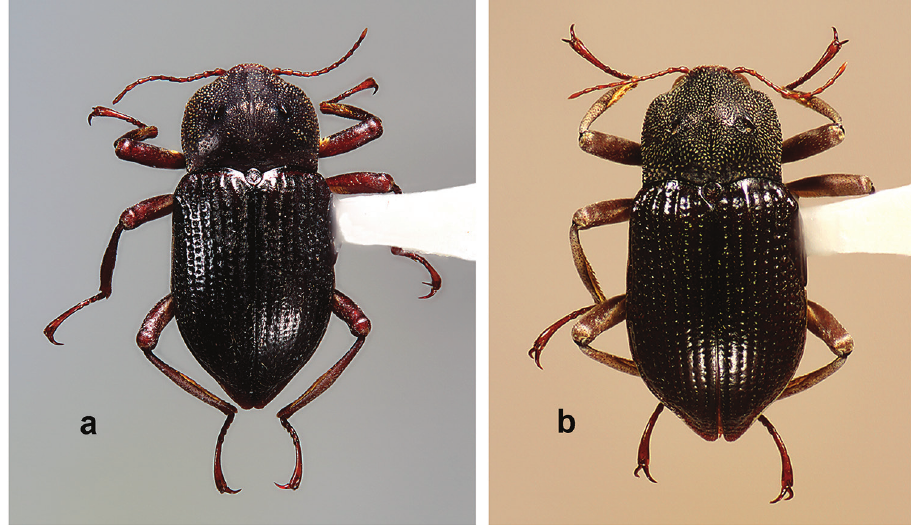
Figure 3. Amazonopsis theranyi sp. n. females, dorsal habitus a Paratype from Peru, length 4.00 mm b Non-paratype from French Guiana, length 4.15